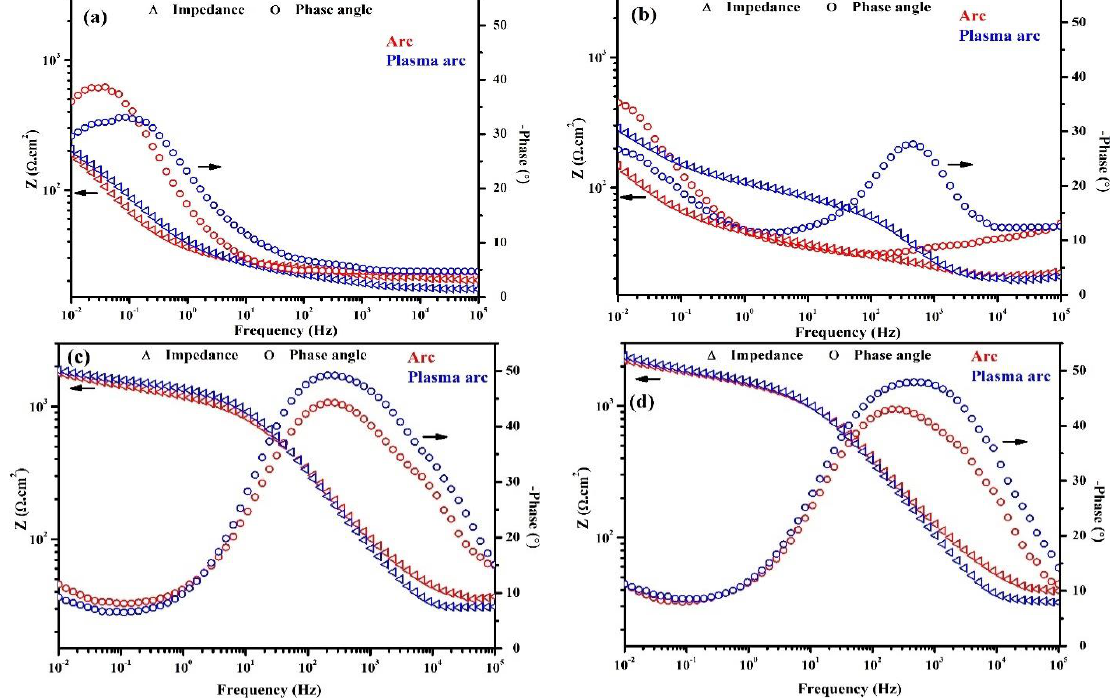
Figure 8. Bode plots of the Zn coatings deposited by different processes after ( a ) 1 h, ( b ) 1 d, ( c ) 13 d, and ( d ) 23 d of exposure to artificial